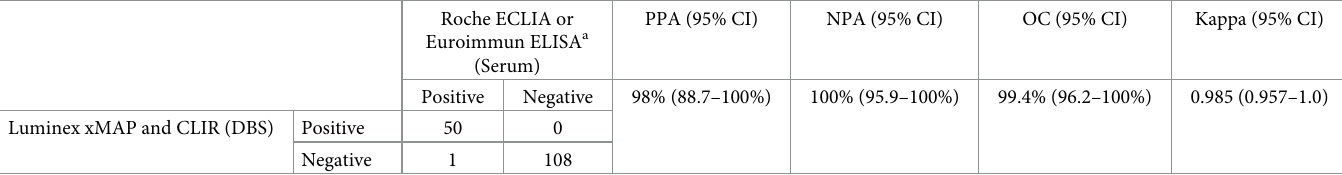
Table 4. Anti-SARS-CoV-2 antibody result comparison between 159 DBS samples tested by the Luminex xMAP assay and interpreted using CLIR, and matched serum samples tested by reference serology assays.